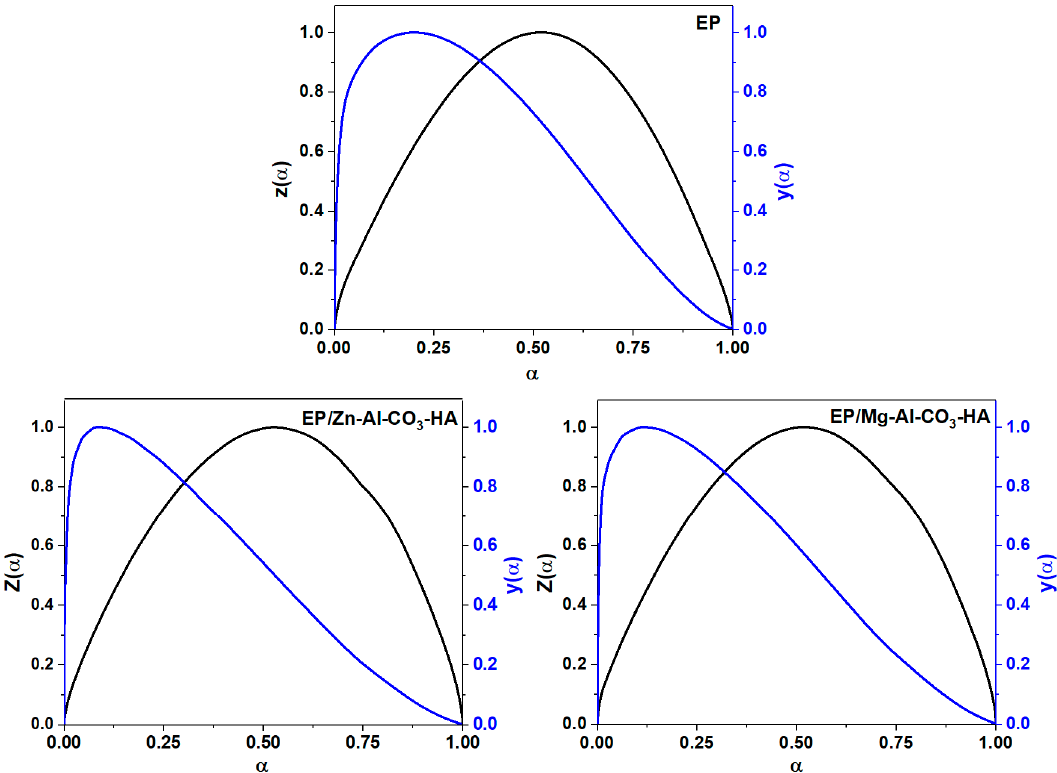
Figure B2. y( α ) and Z( α ) curves as a function of α for prepared samples based on the Málek model.